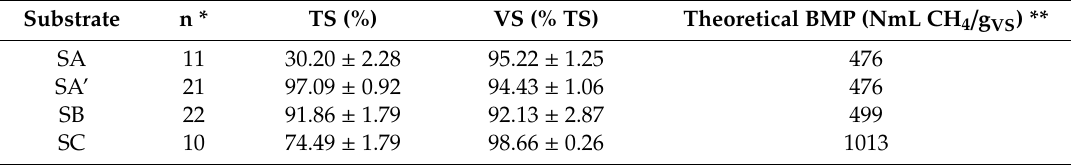
Table 5. Composition of the substrates used in the inter-laboratory study.